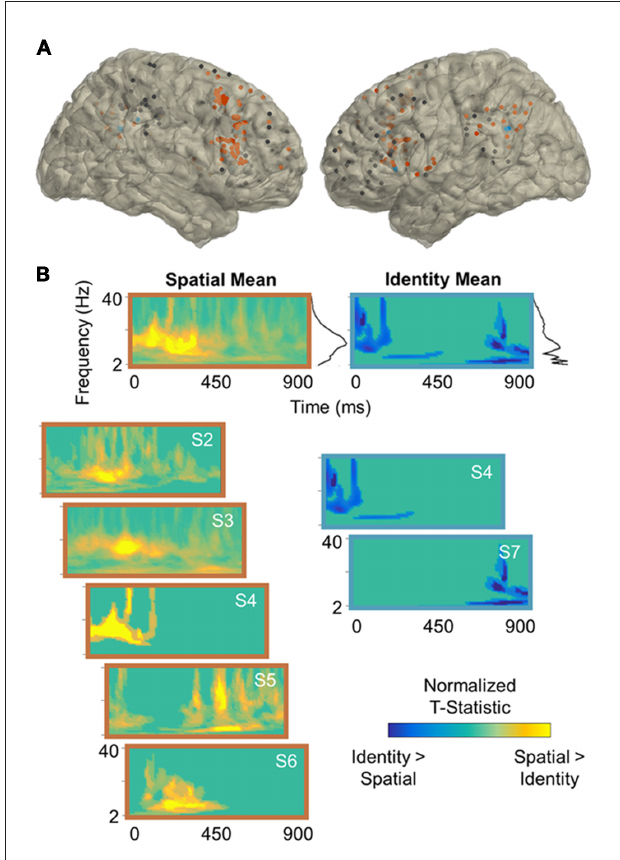
FIGURE 2 | Spatial processing power effects. (A) Reconstruction of frontoparietal electrode coverage for all subjects. Electrodes are color-coded according to the results of the per-subject contrast between identity and spatial trials: orange, spatial > identity; blue, identity > spatial; black, no effect. All effects are significant at the cluster-corrected threshold of 0.05. (B) Mean and per-subject time-frequency representations of significant t -statistics (cluster-corrected mask applied) for the electrodes indicated in (A) . The black lines to the right of the means indicate the spectral density of the corresponding time-frequency representations (i.e., mean significant t -values per frequency). Frequencies range from 2 Hz to 40 Hz in linearly-spaced steps of 1 Hz. T -statistics are normalized according to the maximum value of each plot (scale: − 1 to +1) and color-coded by the direction of effects: cooler, identity > spatial; warmer, spatial > identity. S,